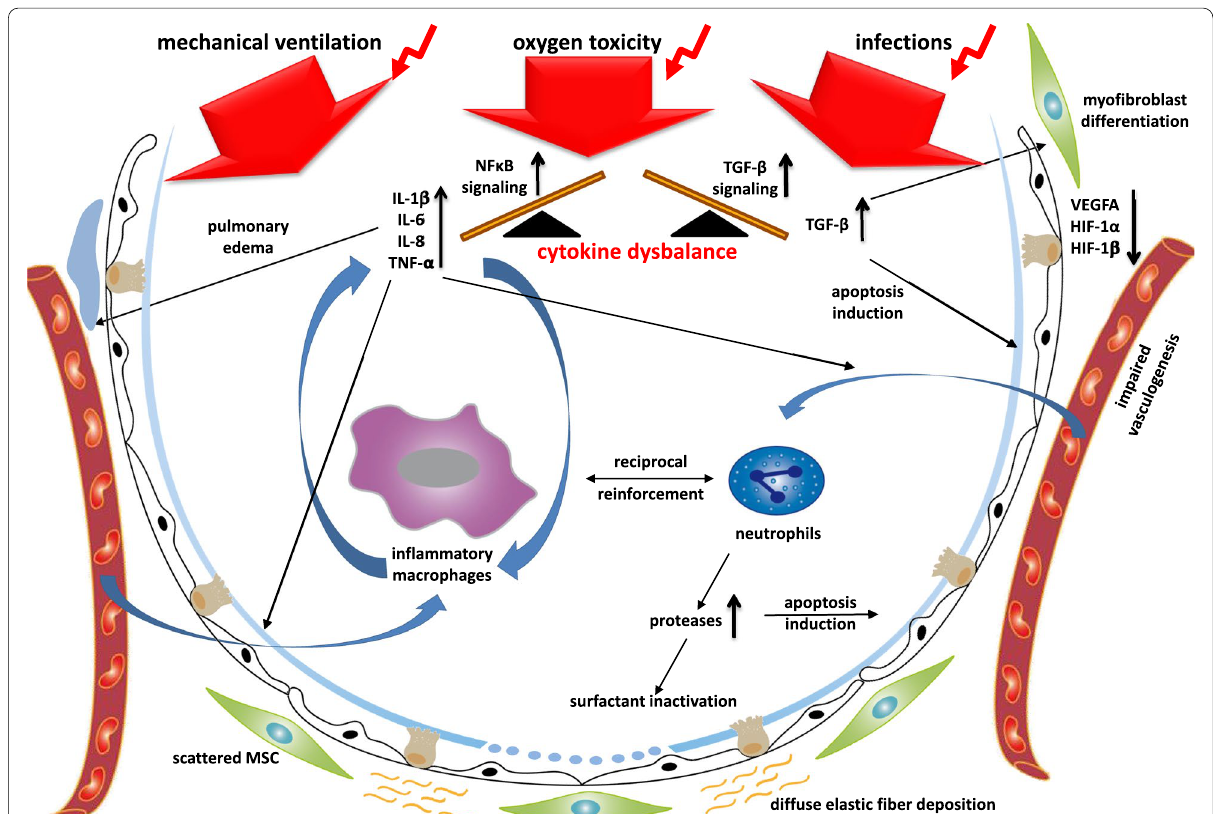
Fig. 2 The inflammatory response in the immature lung as key event leading to bronchopulmonary dysplasia. Mechanical ventilation, oxygen supply and infections induce a pro‑inflammatory response in the immature lung. This pro‑inflammatory overweight disrupts the balanced network of growth signal pathways and leads to characteristic features in the lung that affect the epithelium, the mesenchyme and the endothelium (scheme developed from our previous review on the topic